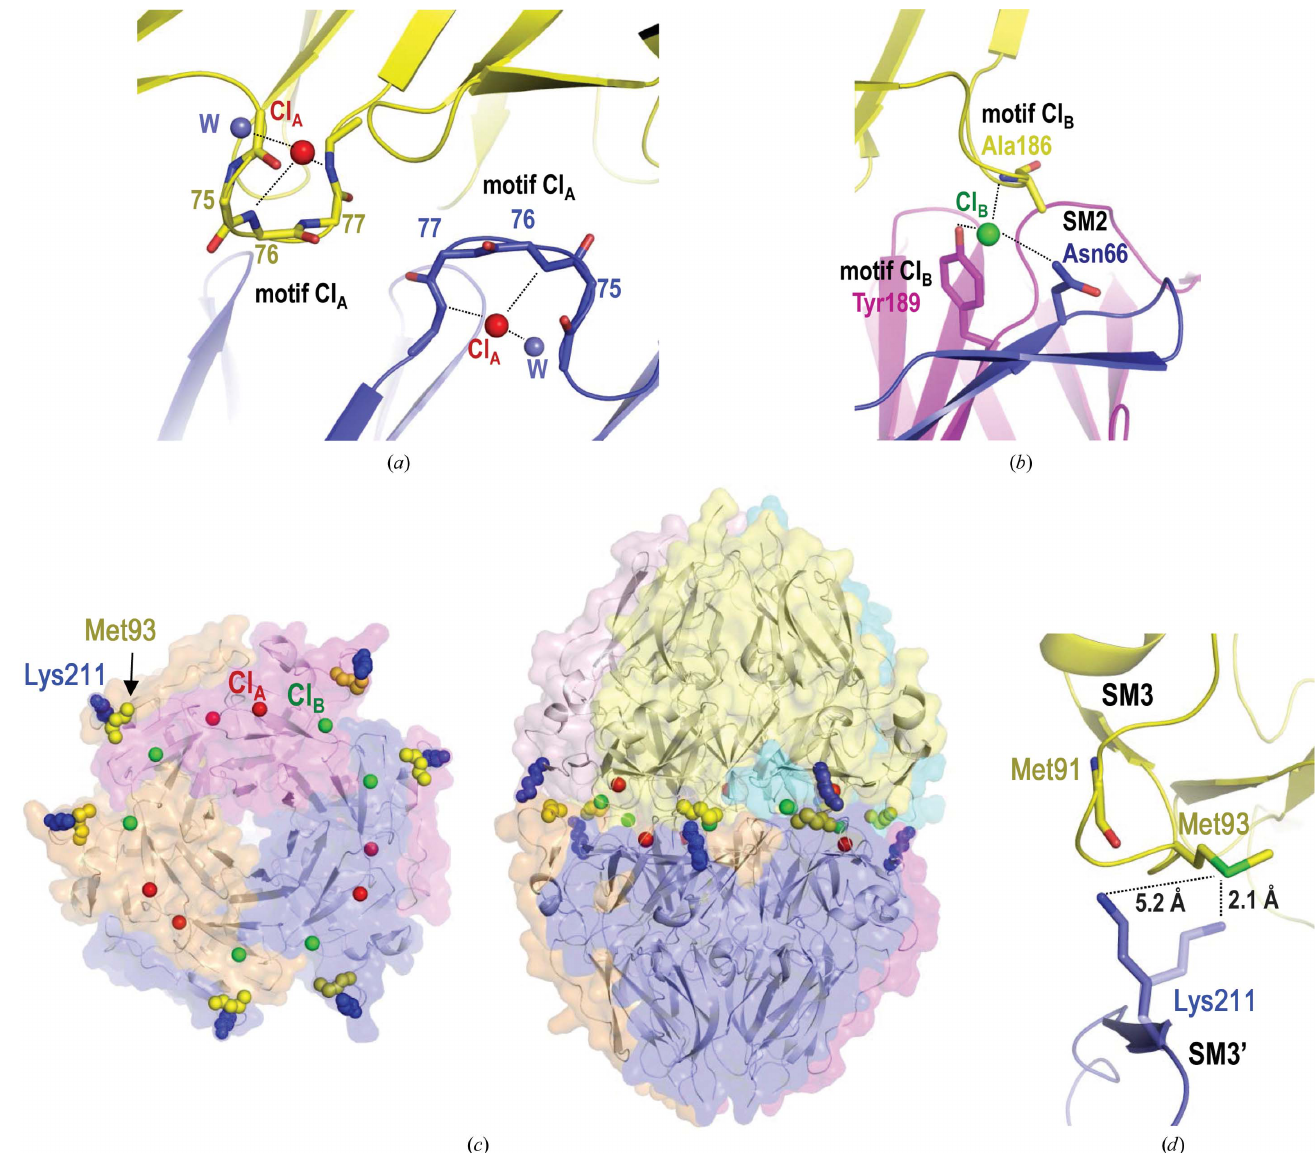
Figure 4 Hexamer stabilization through ion binding and potential sulfilimine-bond sites. ( a ) The chloride ion Cl A (red) interacts with the main-chain amino groups of L (cid:3) 7 (cid:3) 8 (Cl A motif) and a water molecule (blue) in two opposing monomers. ( b ) The chloride ion Cl B (green) binds to residues of flexible regions from three opposing monomers in the Cl B motif (Ala186 in L (cid:3) 7 0 (cid:3) 8 0 and Tyr189 in (cid:3) 8 0 ) and Asn66 in SM2. ( c ) Semi-transparent surface representation (enclosing a cartoon representation) of the equatorial view of the protomer in the canonical (cid:2) 1NC1 homo hexamer indicating the six Cl A ions (red) and six Cl B ions (green) at the interface between the protomers in the hexamer. In addition, the six interfacial Met93 residues (yellow) and the six Lys211 residues (blue), three from the shown protomer and the other three from the top protomer (not shown), are also indicated to stress their proximity, which allows easy sulfilimine-bond formation. These residues and the Cl A and Cl B ions are also shown in the view of the complete (cid:2) 1NC1 homo hexamer illustrated on the right. ( d ) Zoom on the flexible L (cid:3) 8 (cid:3) 9 (SM3) and (cid:3) 9 0 (SM3 0 ) regions of opposing monomers, highlighting the closeness of the Met93 and Lys211 residues of each region, respectively. A mere rotamer change of Lys211 would place it in position for the formation of a sulfilimine bridge with